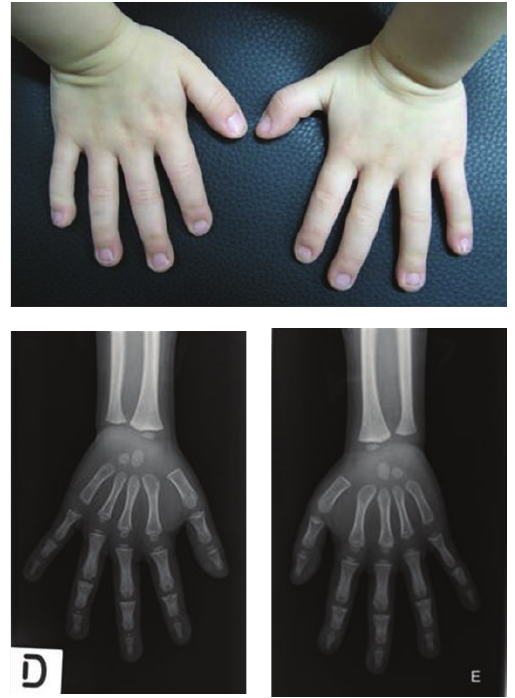
Figure 2: Photograph and radiograph of a 4-year-old girl’s hands, showing short metacarpals and metaphyseal concavity involving the proximal phalanges of the thumb and small finger and all the middle